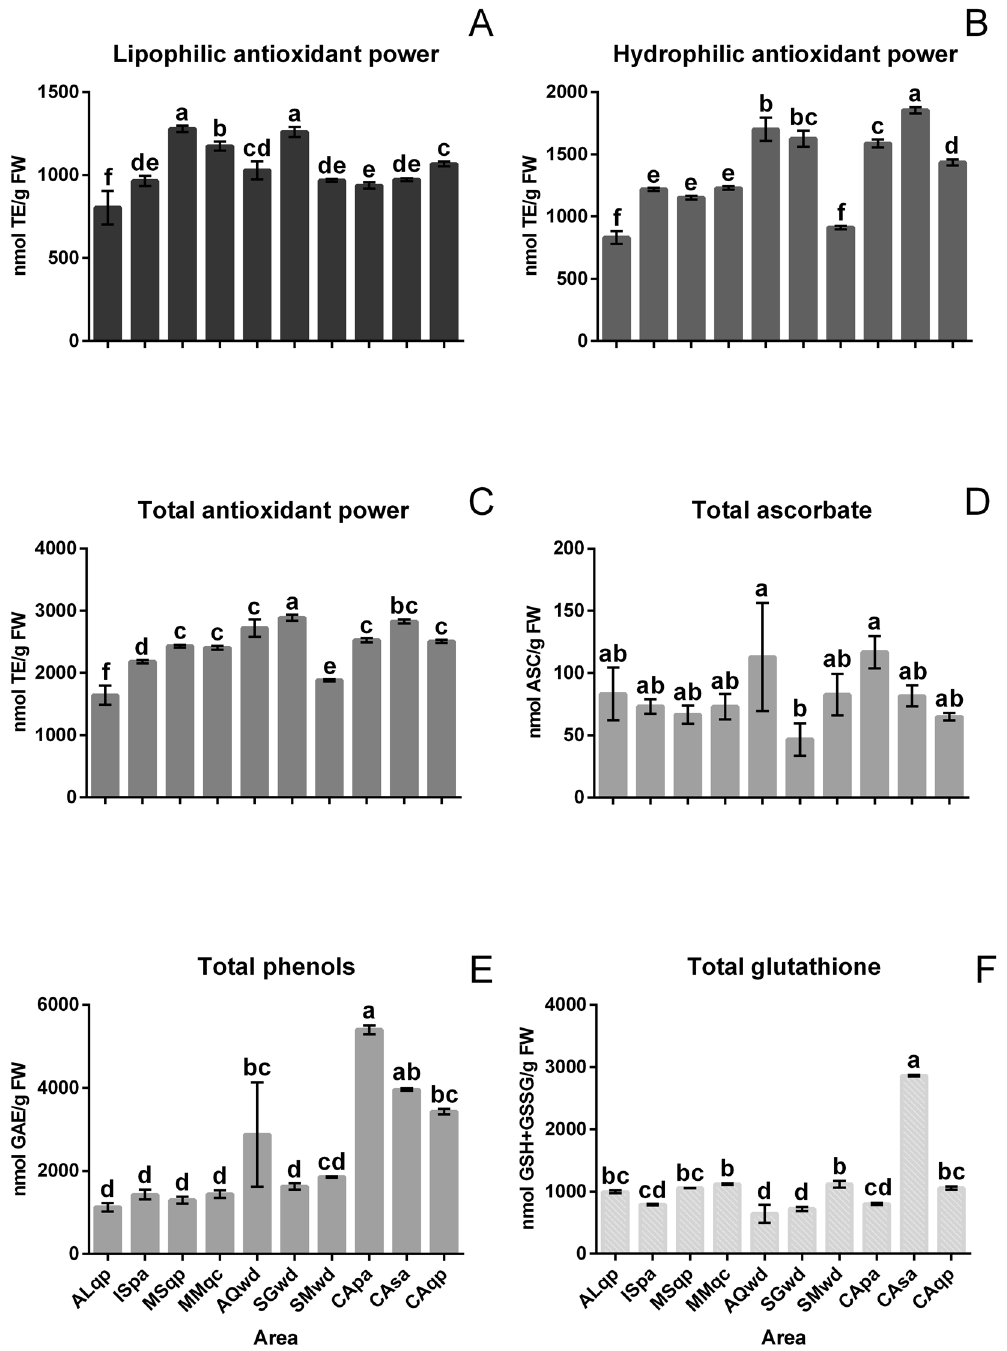
Figure 4. Antioxidant activity and relevant antioxidant compounds in the truffle samples. Tukey-HSD test was performed post hoc with a confidence level of 95% following an ANOVA. Values are the mean ± the standard deviation (n = 4). The sample details are shown in Table